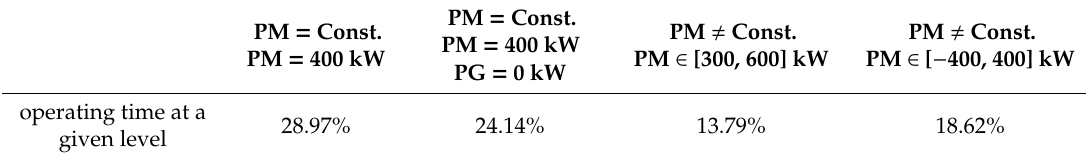
Table 1. The time for which the private network works on a given margin. PM =